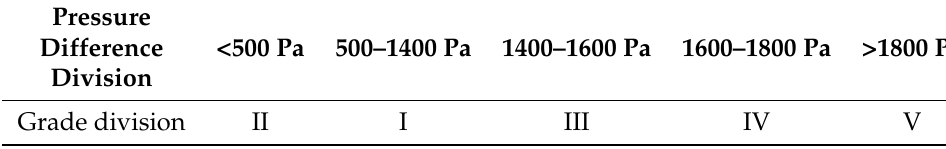
Table 4. Classification of pressure difference risk levels between inlet and